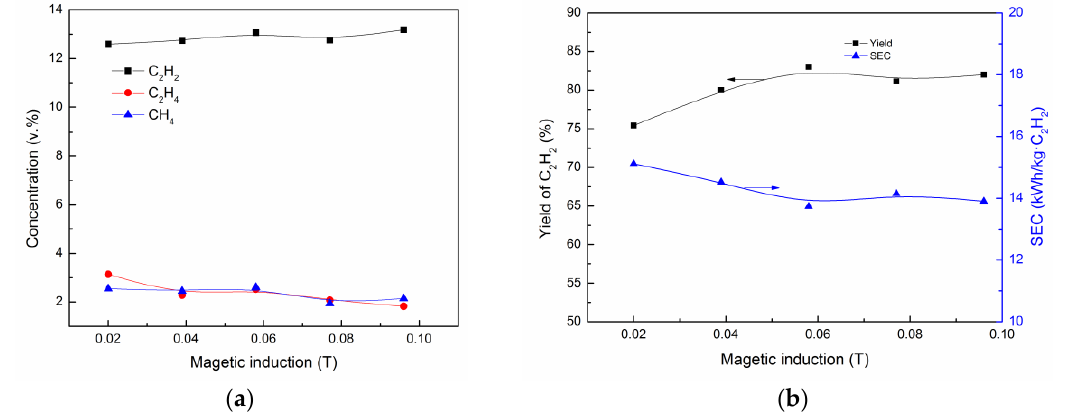
Figure 7. The effect of magnetic induction on the performance of n- hexane pyrolysis: ( a ) concentration in product gas; ( b ) C 2 H 2 yield and SEC. Reaction conditions: R H/C = 6.3, m- n- hexane = 27.4 g/min, B = 0.02–0.10 T, I = 80 A, P = 17.0 kW.